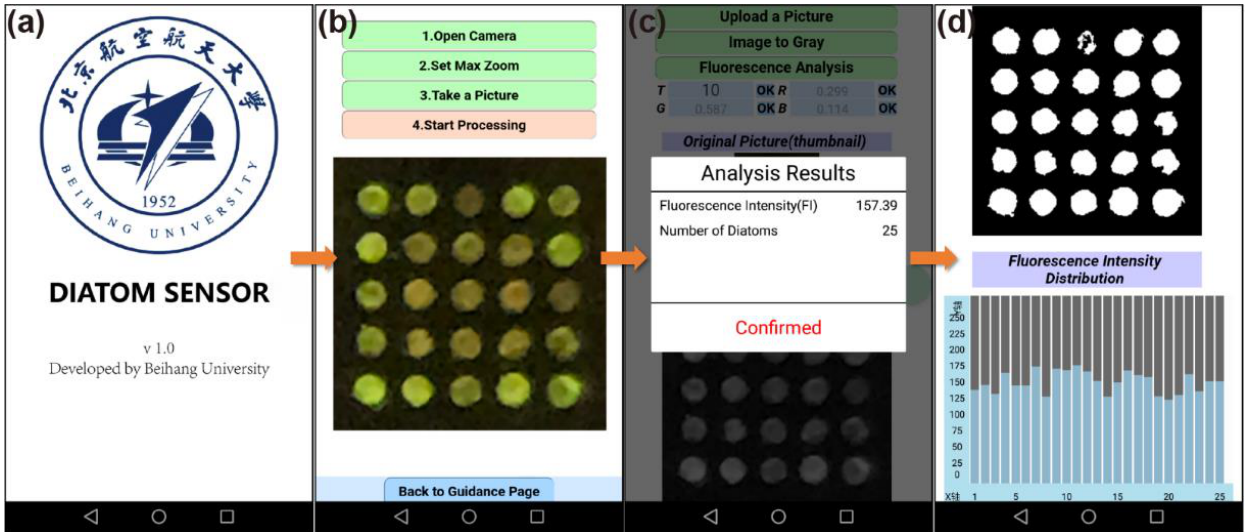
Figure 4. Pictures of the app interface. ( a ) Start-up screen; ( b ) Fluorescence photo capture interface; ( c ) Photo-processing interface and result output; ( d ) Binary map of fluorescence photo and distribution chart of fluorescence intensity.